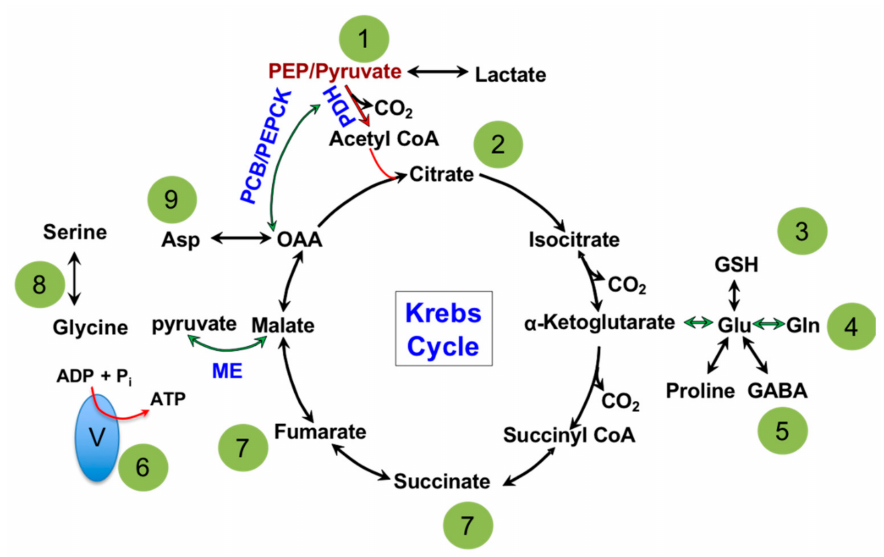
Figure 1. Major pathways and metabolite exchange that take place in the mitochondria. 1: